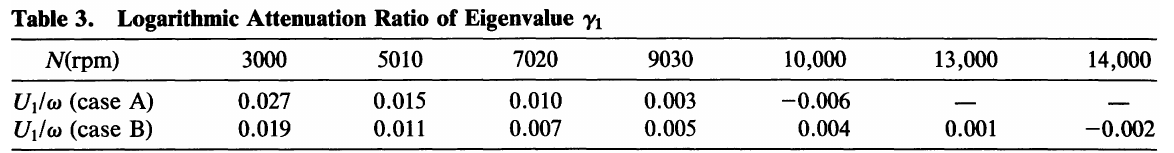
Table 3. Logarithmic Attenuation Ratio of Eigenvalue